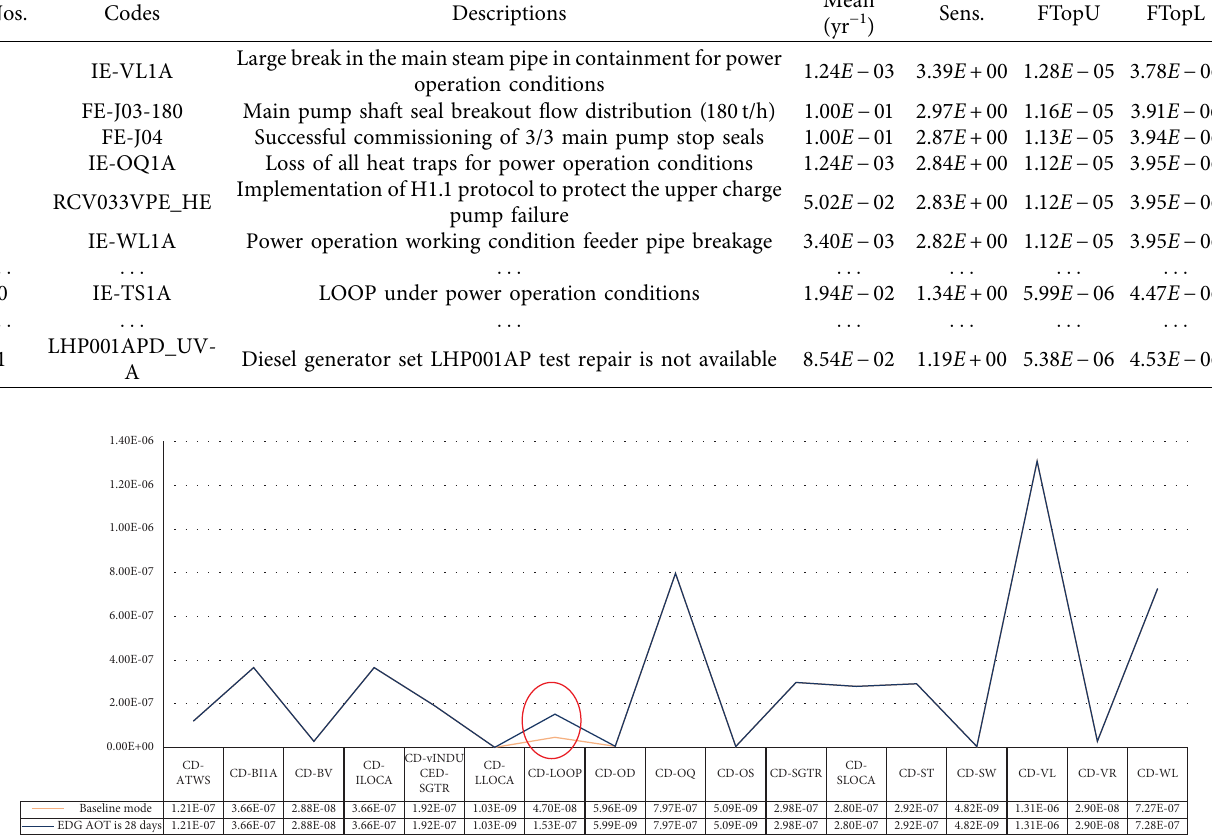
Figure 7: Values of baseline case with EDG AOT at 28 days for initiating Table 5: Sensitivity analysis.